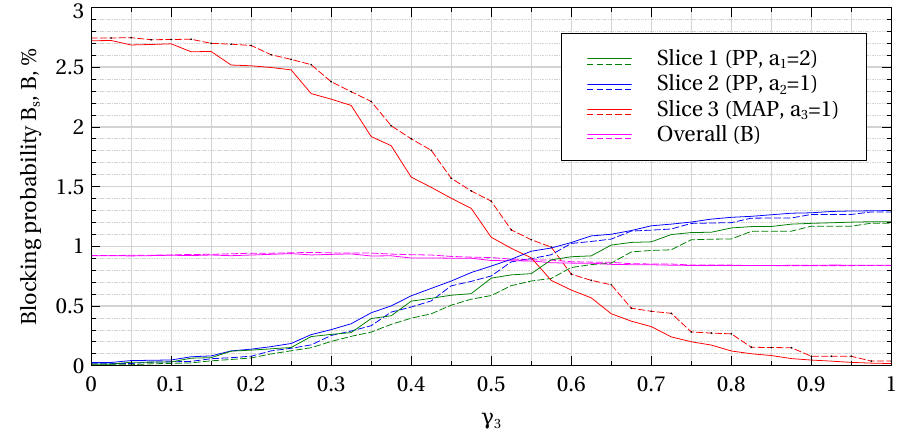
Figure 4. The blocking probabilities vs. γ 3 ; γ 2 = α − γ 3 lines— α = 1.1).